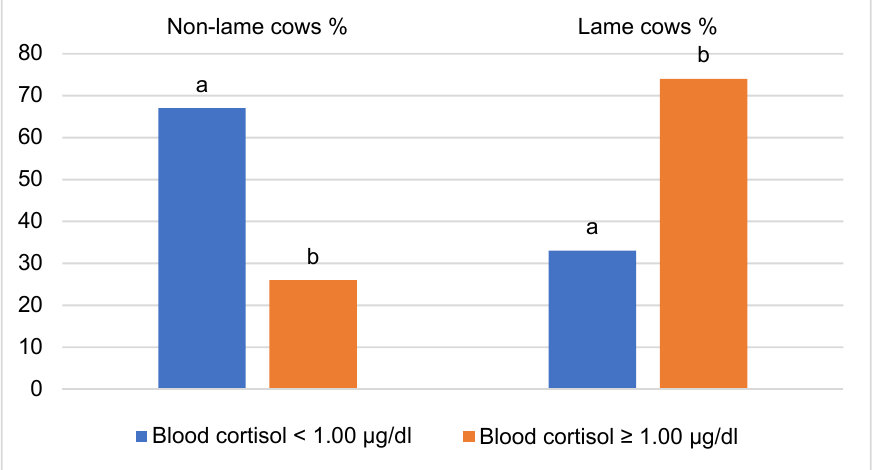
Figure 1. Distribution of non-lame and lame cows by blood cortisol level. a, b —different letters indi- cate that the difference in the frequencies of the groups in terms of blood cortisol level is statistically significant ( p < 0.05). Table 2. The percentage of non-lame and lame cows based on milk electrical conductivity levels in different phases of milk flow.